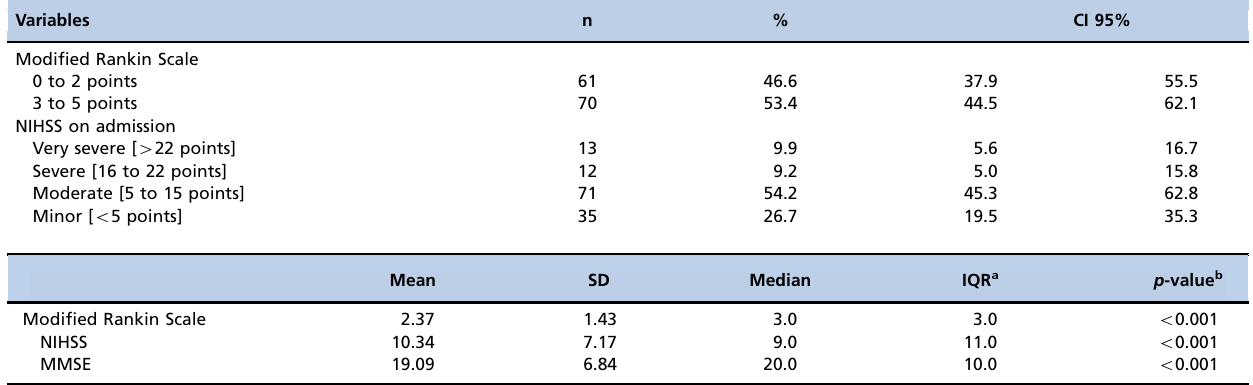
Table 1 - Clinical Staging of ischemic stroke patients. Variables